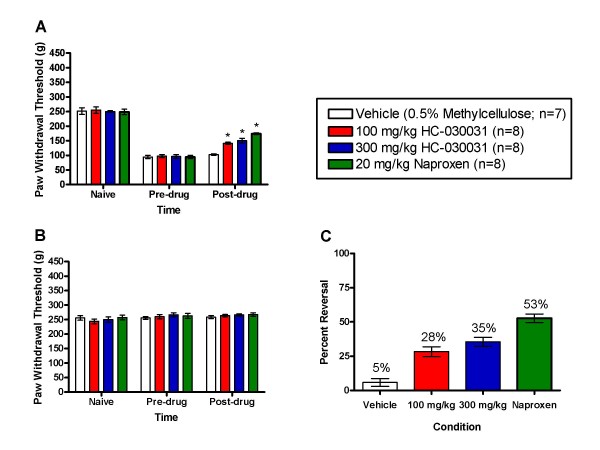
The effect of TRPA1 antagonism on complete Freund's adjuvant induced mechanical hypersensitivity. A. Paw withdrawal thresholds for the injected hind paw were assessed using the Randall-Selitto device prior to intraplantar CFA injections, prior to dosing with vehicle (white bars), 20 mg/kg naproxen (green bars), 100 mg/kg HC-030031 (red bars) or 300 mg/kg HC-030031 (blue bars), and at one hour post p.o. dosing. Naproxen, 100 mg/kg and 300 mg/kg HC-030031 produced a significant attenuation in mechanical hypersensitivity at one hour post dose (*p < 0.05). B. Paw withdrawal thresholds for the noninjected hind paw assessed using the Randall-Selitto device prior to intraplantar CFA injections, prior to dosing with vehicle (white bars), 20 mg/kg naproxen (green bars), 100 mg/kg HC-030031 (red bars) or 300 mg/kg HC-030031 (blue bars), and at one hour post p.o. dosing. C. Percent reversal seen at one hour post p.o. dosing with vehicle (white bars), 20 mg/kg naproxen (green bars), 100 mg/kg HC-030031 (red bars) or 300 mg/kg HC-030031 (blue bars).